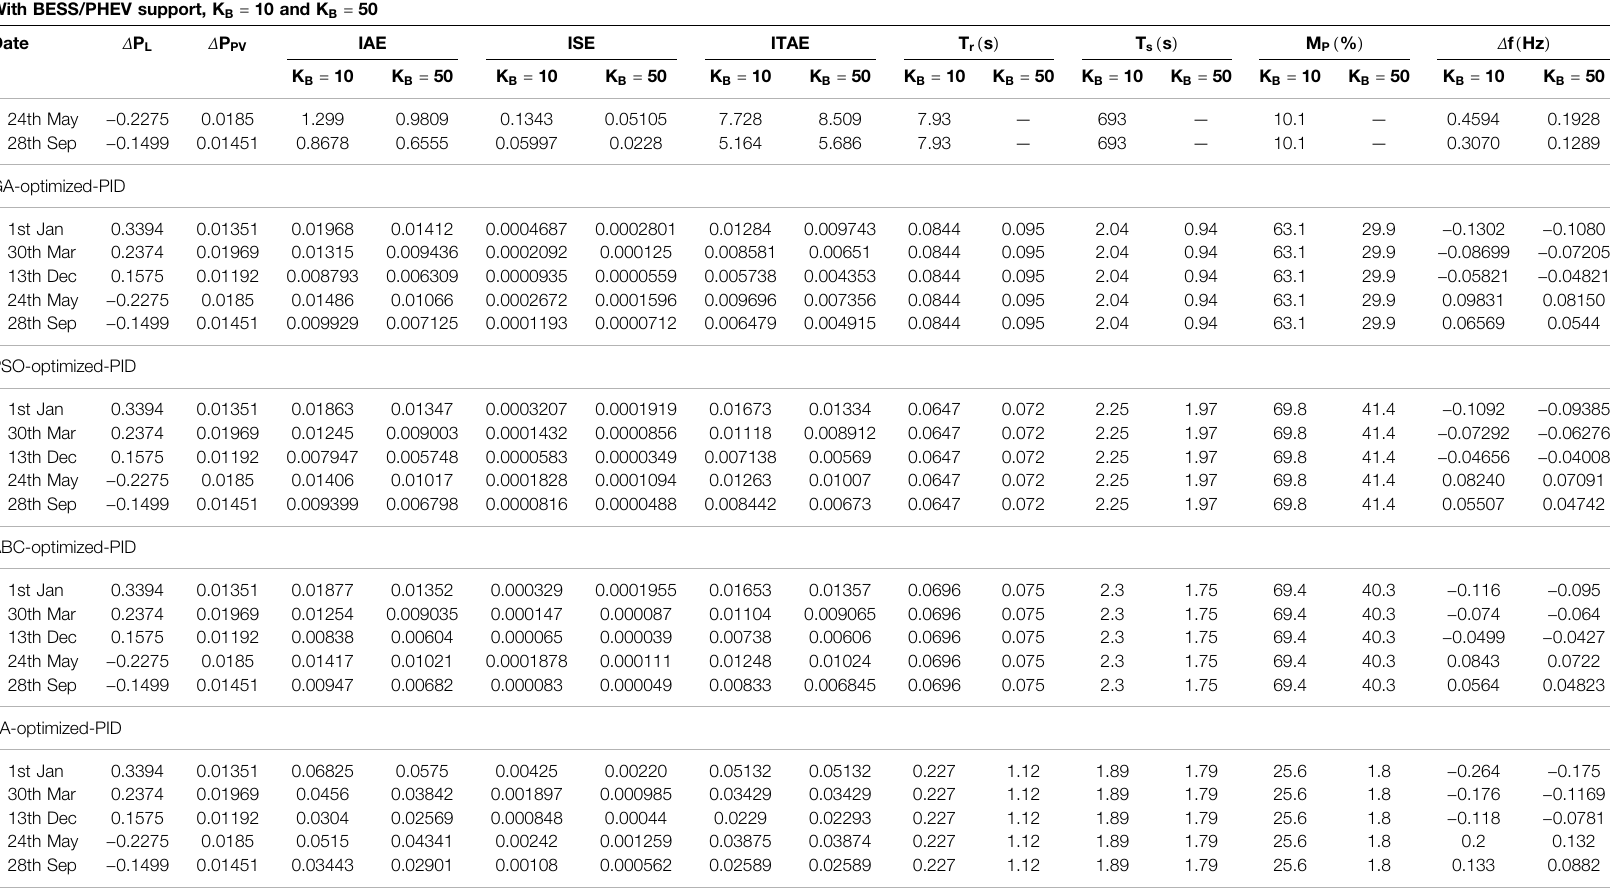
TABLE 8 | ( Continued ) Frequency deviation parameter indices using integral time absolute error objective